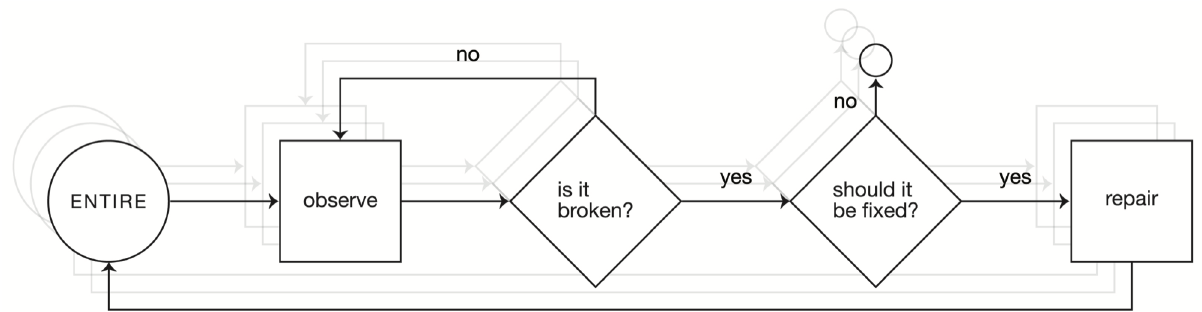
Figure 5 | Non-Self-Healing Thing – External decision